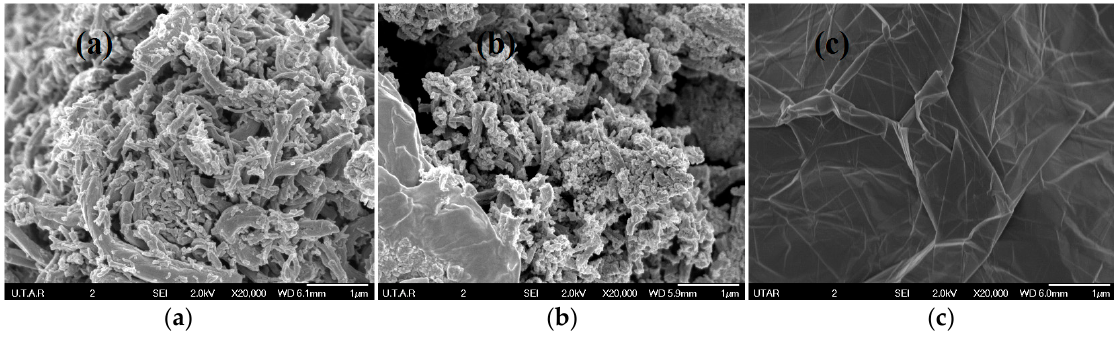
Figure 9. SEM images of ( a ) GNF; ( b ) GO; ( c ) RGO.